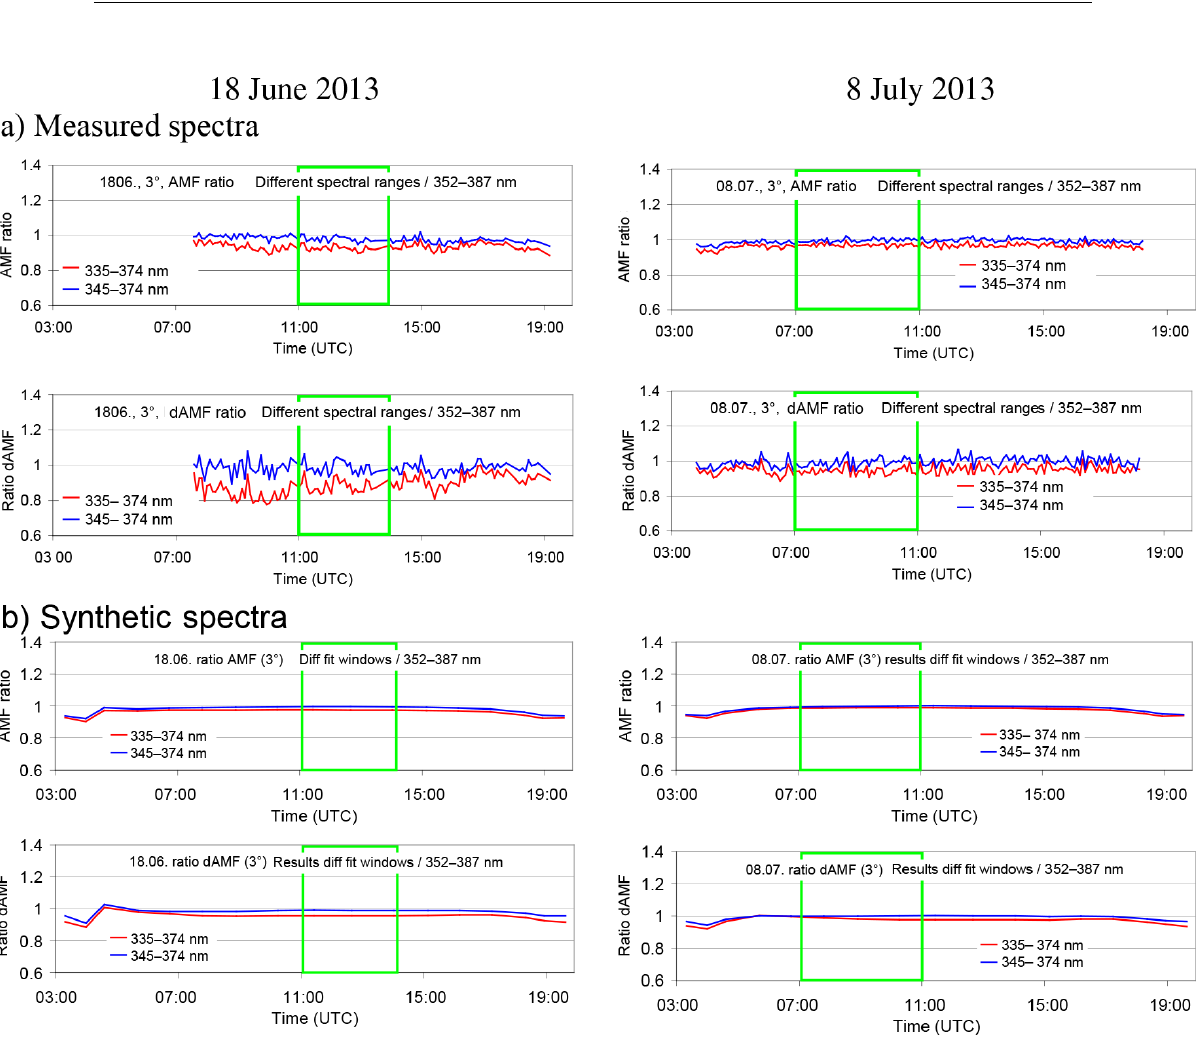
Figure A15. Ratios of the O 4 (d)AMFs derived for different fit windows vs. those for the standard fit window (352–387nm) for both selected days ( a : results for spectra measured by the MPIC instrument; b : results for synthetic spectra when taking into account the temperature dependence of the O 4 cross